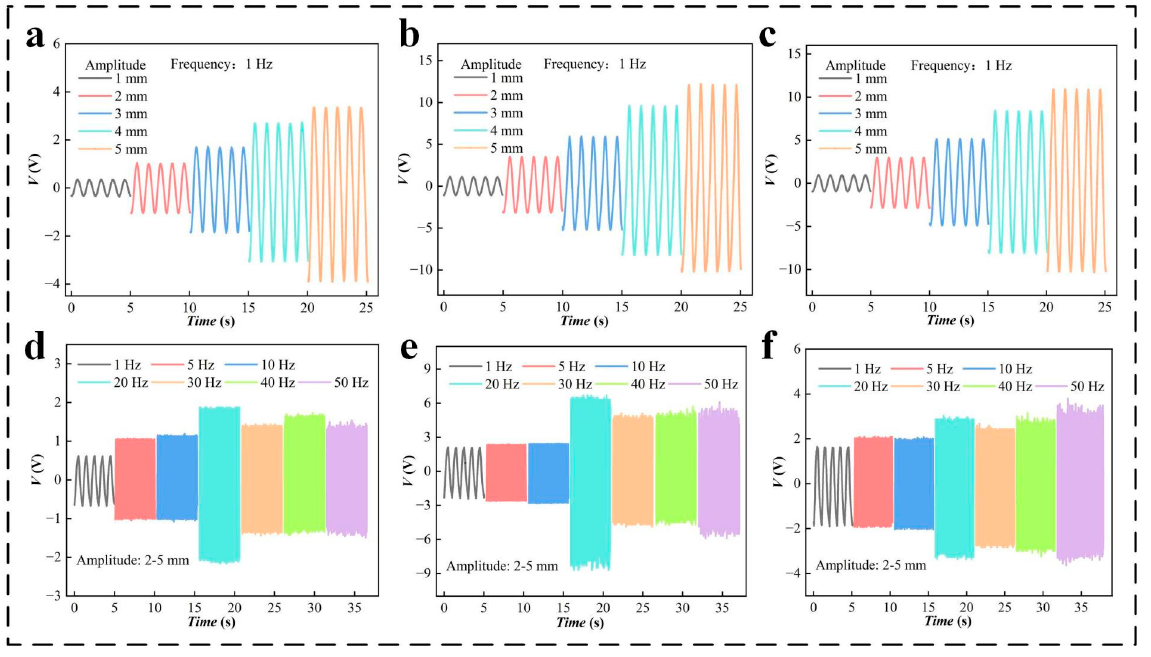
Figure 4. The output performance of PZT units under different amplitudes and frequencies of vibration: ( a – c ) voltage ( V ) of PZT units of different specifications for a stroke of the motor of 1, 2, 3, 4, and 5 mm, ( d – f ) V of PZT units of different specifications for a frequency of excitation of 1, 5, 10, 20, 30, 40, and 50 Hz.